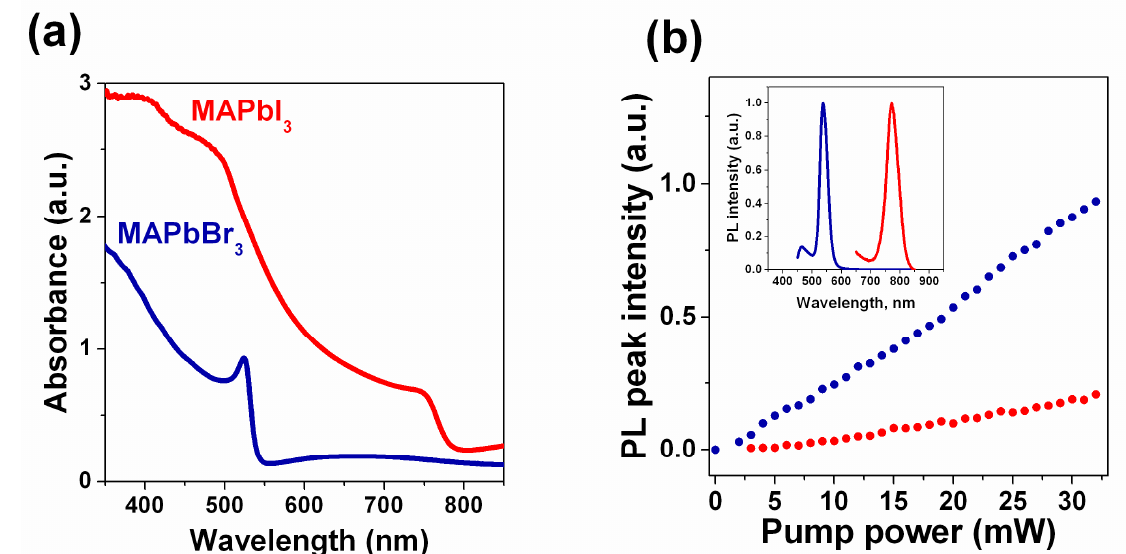
Figure 3. Steady-state optical properties of synthesized polycrystalline MAPbI 3 and MAPbBr 3 films placed on glass substrates. ( a ) Optical transmission spectra; inset shows the typical SEM image of an MAPbI 3 film; ( b ) photoluminescence spectra obtained under excitation with a 400 nm laser diode; ( b ) the dependence photoluminescence (PL) peak intensity on pump power. Blue and red colors correspond to MAPbBr 3 and MAPbI 3 samples, respectively. Inset demonstrates the corresponding normalized PL spectra.